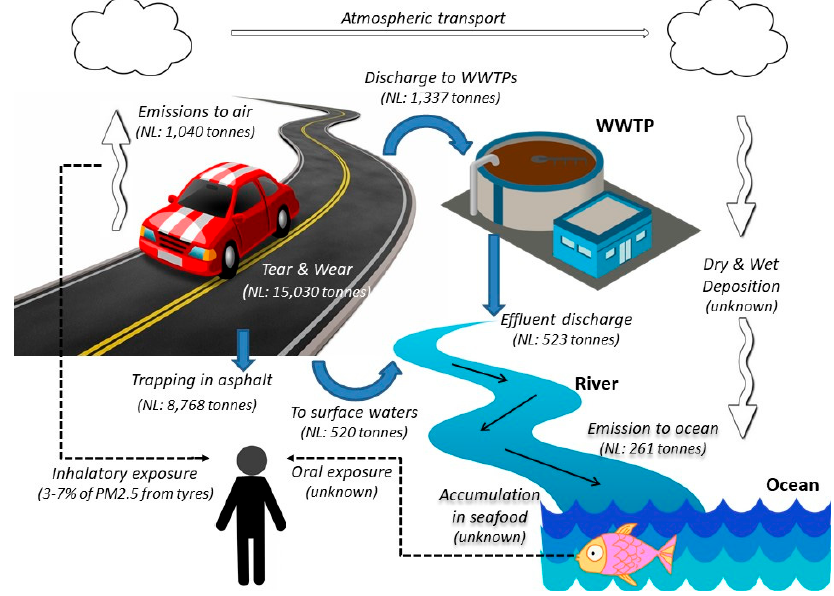
Figure 3. Distribution of the tyre wear and tear over the compartments. WWTP: waste water treatment plants; NL: The Netherlands.